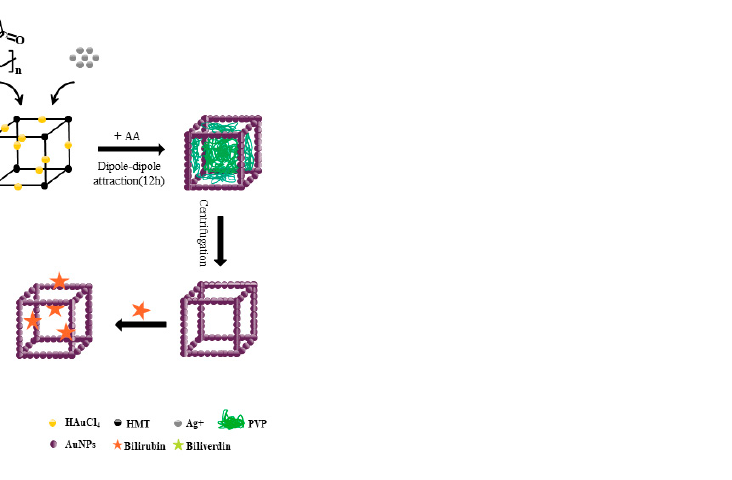
Scheme 1. The schematic diagram for the synthesis of GNCs and their interaction with